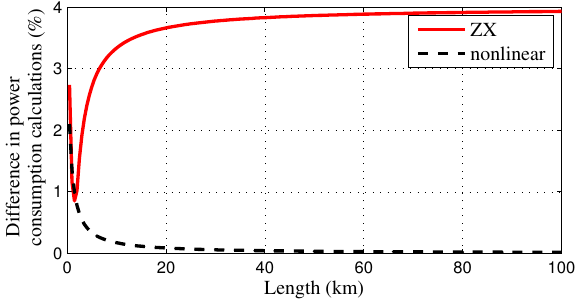
Figure 4. Percentage differences in power consumption calculations for the ZX and non-linear models relative to the proposed